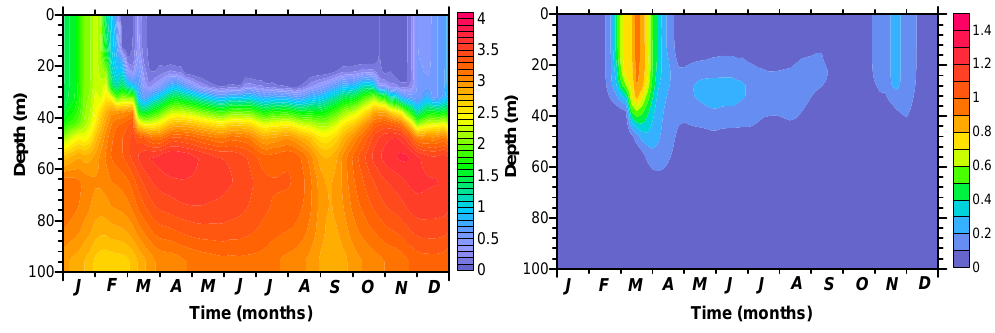
Figure 16 Seasonal cycle of averaged over the basin area phytoplankton derived from Fig. 16. Seasonal cycle of averaged over the basin area phytoplankton derived from modelling (left panel) and chlorophyll seasonal cycle in modelling (left panel) and chlorophyll seasonal cycle in the upper layer of the Black Sea on the upper layer of the Black Sea on the basis of in-situ measurements (Vedernikov and Demidov, 1997). the basis of in-situ measurements (Vedernikov and Demidov, 1997)